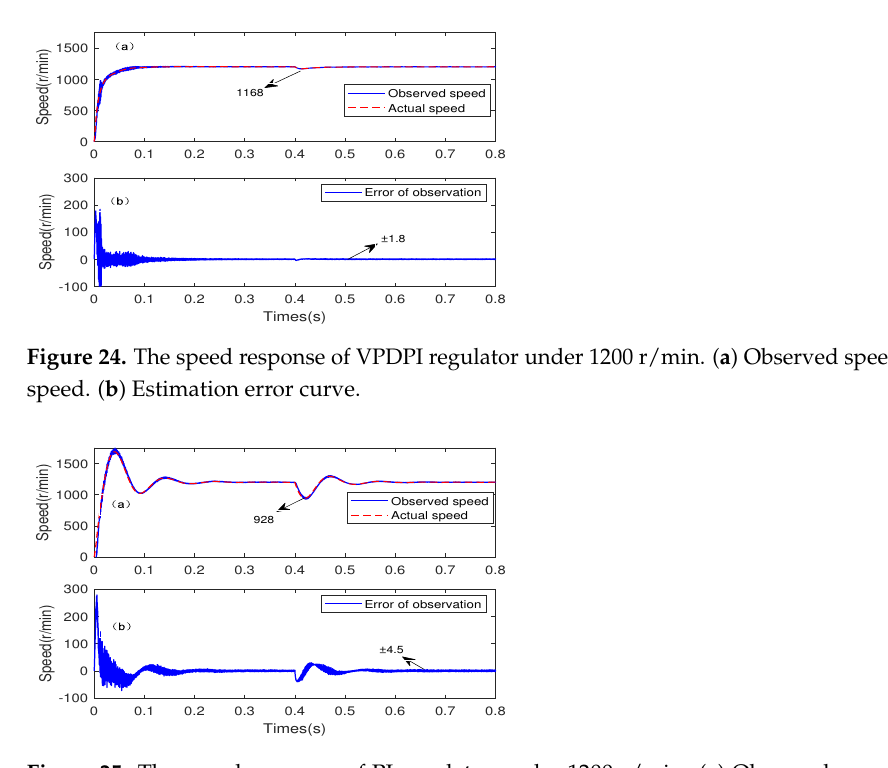
Figure 25. The speed response of PI regulator under 1200 r/min. ( a ) Observed speed and actual speed. ( b ) Estimation error